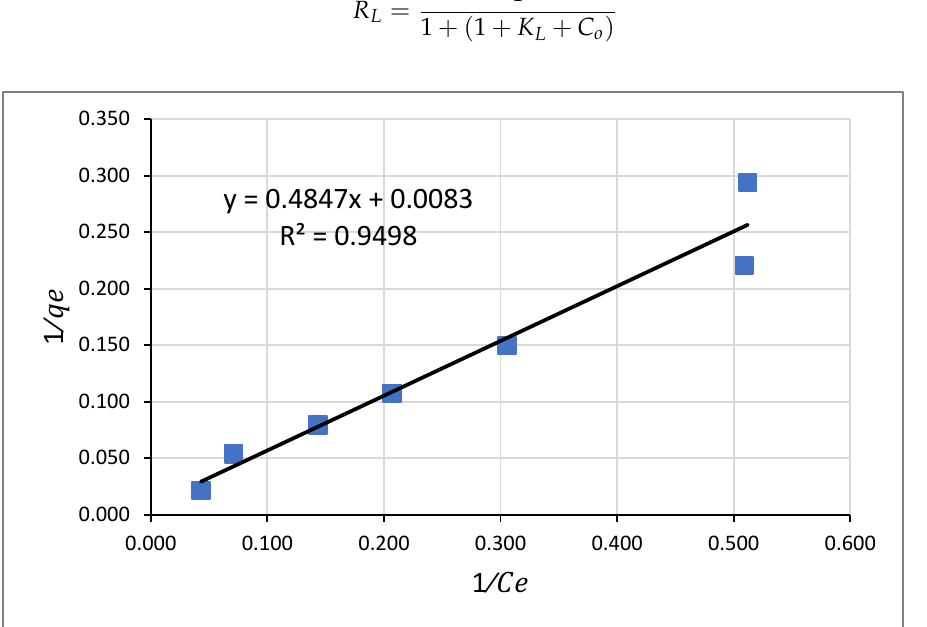
Figure 10. Langmuir Adsorption Isotherm Model for Lead (II). Table 8. Langmuir and Freundlich isotherm model constants for adsorption of Pb 2+. Adsorbent.